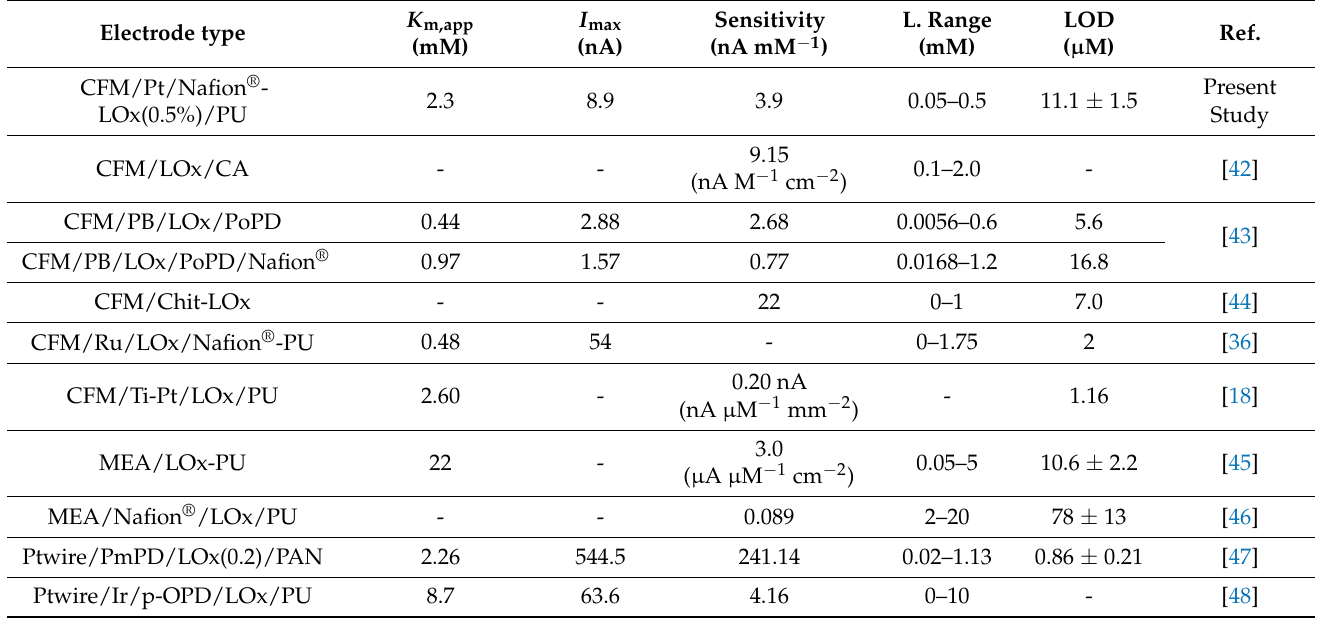
Table 2. Enzyme kinetics and analytical parameters of lactate microbiosensors.